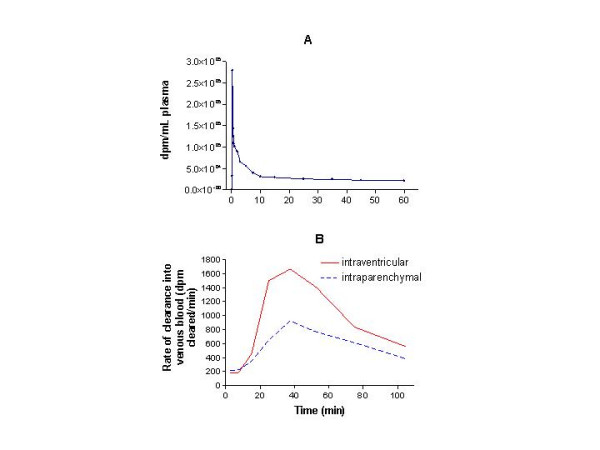
Calculation and graphing of the emergence function, i.e., the rate of appearance of 125I-activity in venous blood. 4A. The time-course of radioactivity concentration in arterial plasma after an intravenous bolus injection of 125I-IGF-1. 4B. The emergence function calculated from the arterial plasma concentration-time curve following intravenous injection plus the arterial plasma curves following intraventricular and intraparenchymal infusions. The emergence function is the rate of appearance of the radioactivity in the venous system (dpm/min) and was calculated for 2.5, 7.5, 15, 25, 37.5, 52.5, and 75 min; the breakpoints on the graphs demarcate these times after infusion. The curves were not smoothed although the rates continually change throughout the period of interest.